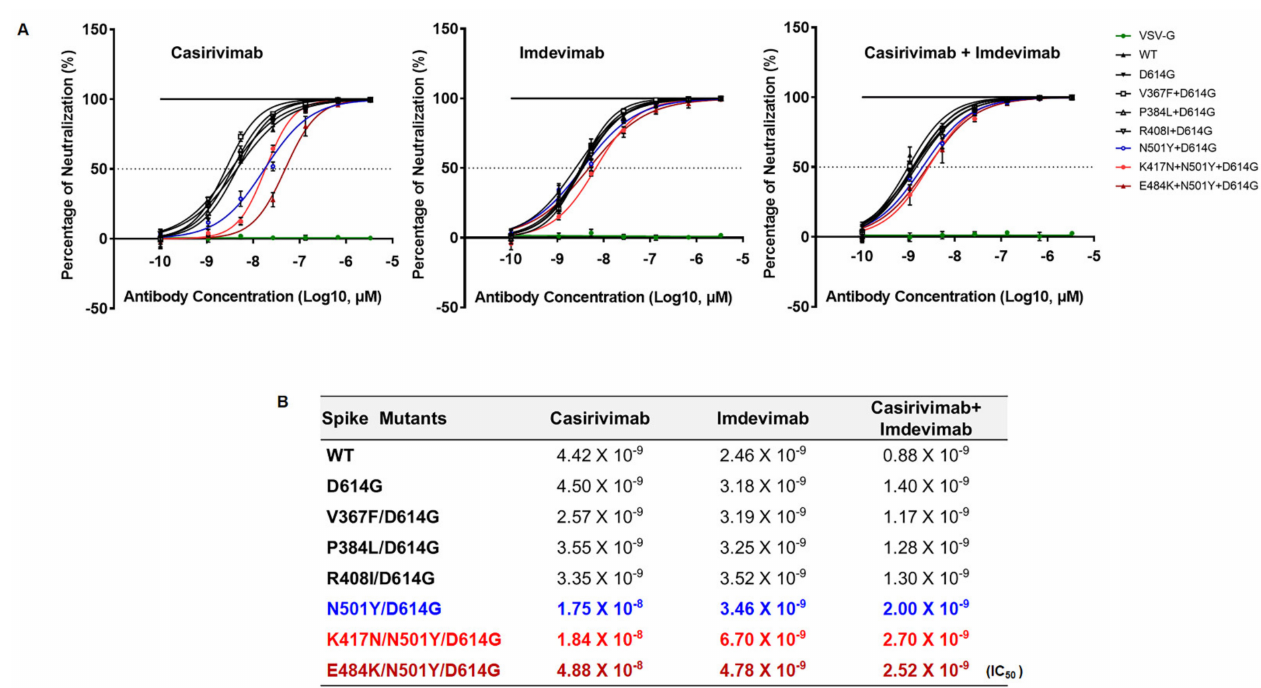
Figure 5. Neutralization assay of SARS-CoV-2 RBD targeting monoclonal antibody against spike RBD variants ( A ) Pseu- doviruses expressing several indicated SARS-CoV-2 spike variants were incubated with two monoclonal antibodies (mAb) (Casirivimab and Imdevimab) with indicated concentration before transduced into 293T-ACE2 cells. After 24 h of incubation, the effect of SARS-CoV-2 spike mutation on mAb neutralization was analyzed by measuring the reduction of luciferase activity. The combination treatment was performed by treating half amount of both mAb. ( B ) IC50 values were calculated by GraphPad Prism 8 and shown for each variant. Red-colored mutants represent mutation from B.1.351 variant. The neutralization efficiency against VSV-G expressing pseudovirus was presented as a negative control for